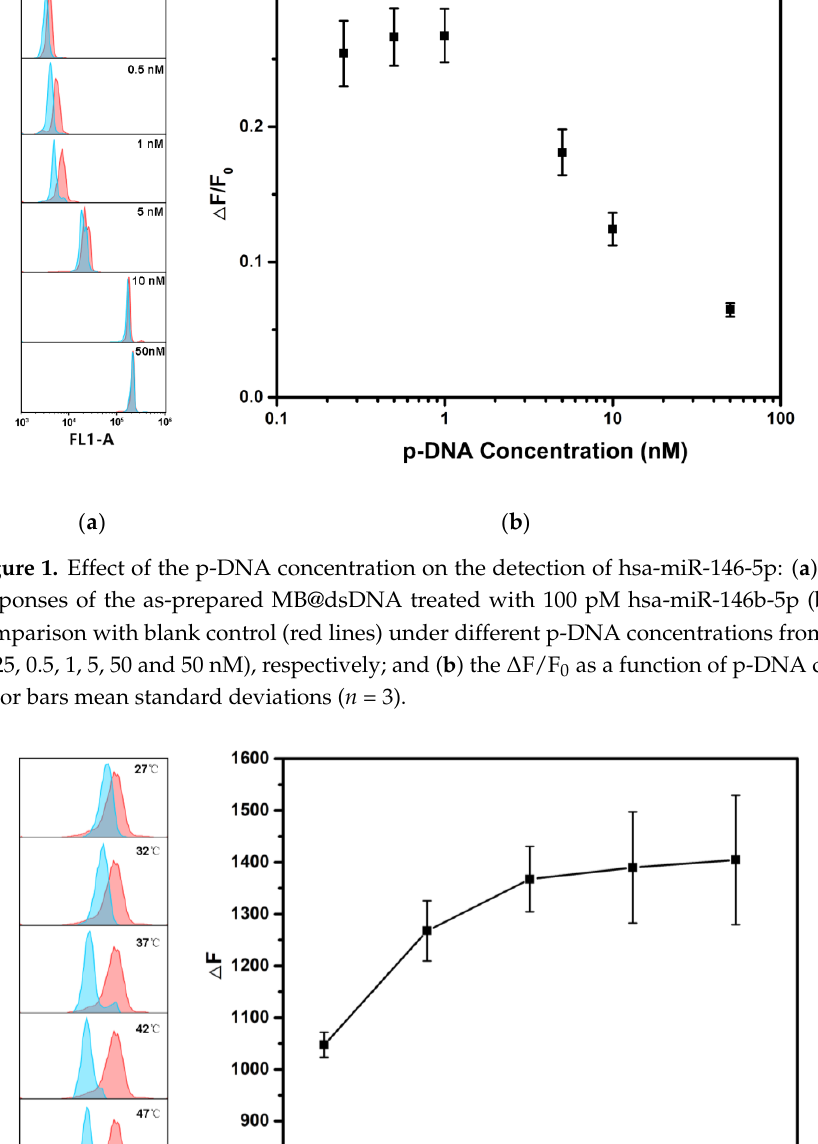
( b ) Figure 3. Effect of the reaction time on the detection of hsa-miR-146b-5p: ( a ) fluorescence re- sponses of the MB@dsDNA treated with 100 pM hsa-miR-146b-5p (blue lines) and blank control (red lines) at 37 °C under different reaction times (20, 30, 40, 50, 60, 70 and 80 min), respectively; ( b ) the corresponding relative fluorescence intensity changes (ΔF) with different reaction times. error bars mean standard deviations ( n = 3). 3.3. Detection Performance of the TSDR-Based Flow Cytometric Assay Under optimal reaction conditions, the fluorescence intensity of MB@dsDNA is de- creased by increasing the concentration of hsa-miR-146b-5p (as shown in Figure 4a). It is